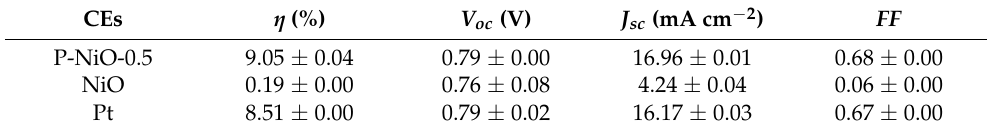
Table 2. Photovoltaic parameters of the DSSCs with the P-NiO-0.5, NiO and Pt CEs, measured at 100 mW cm − 2 (AM1.5G) in front illumination. The standard deviation for the data is based on three cells. CEs η (%) V oc (V) J sc (mA cm − 2 ) FF